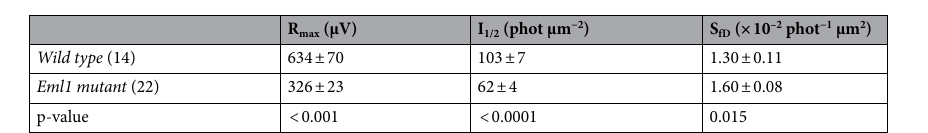
Figure 3. Effect of Eml1 mutation on collective rod responses. Representative rod responses to a family of flashes (photons μm −2 ): 0.3, 1, 3.5, 10, 35, 117, 385, 1270 and 3810 from wild type ( A ) and Eml1 mutant ( B ) mice. For comparison, the responses to a flash of 10 photons μm −2 are highlighted in red. ( C ) Ensemble-average responses of wild type and Eml1 mutant rods plotted as a function of flash intensity. The lines represent Naka- Rushton function fits to the data. ( C , inset ) Average normalized response curve for wild type and Eml1 mutant rods. ( D ) Average normalized sensitivity of wild type and Eml1 mutant mice as a function of background light intensity. The lines represent data fitted to Weber-Fechner function. Error bars show S.E.M for all data.